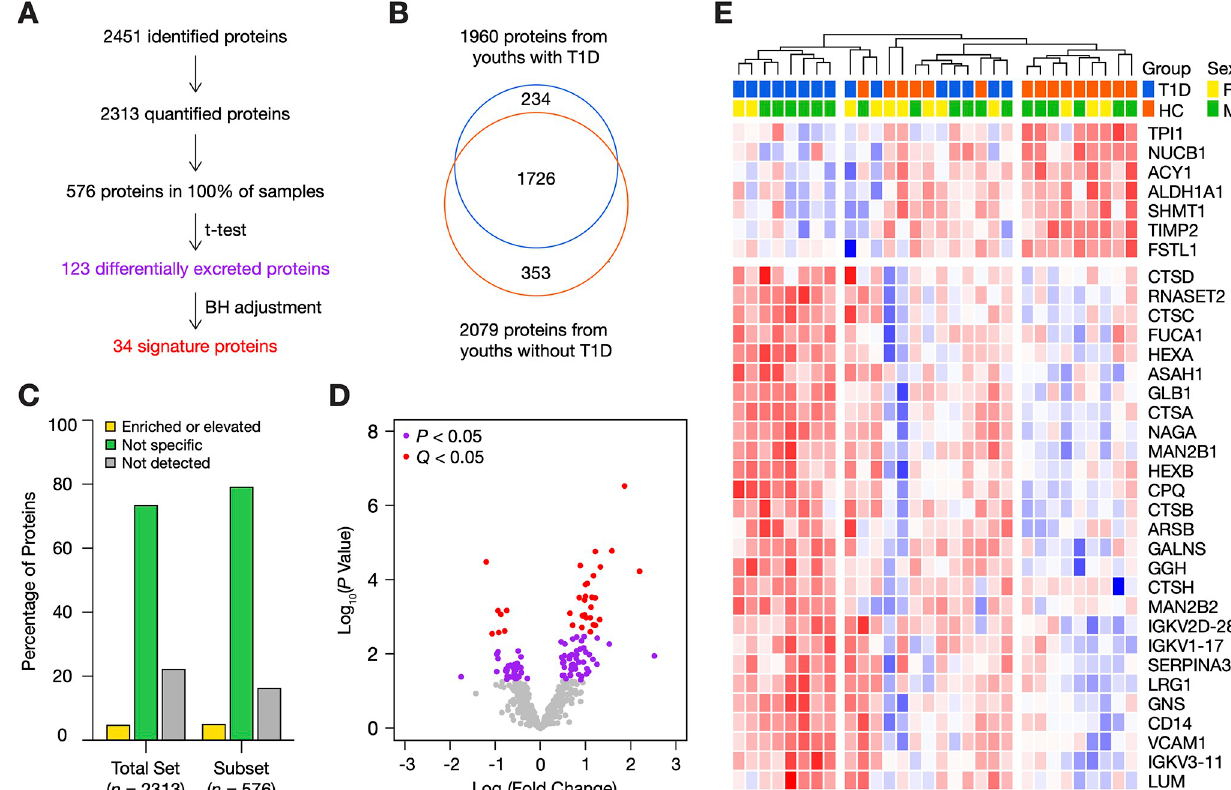
Fig 2. Characterization of the urinary proteomes of 15 youths with type 1 diabetes and 15 non-diabetic peers. (A) Flow diagram for the identification of the urinary signature of early type 1 diabetes. (B) Venn diagram of the 2313 quantified urinary proteins. (C) Kidney tissue origins of the total proteome and the subset of 576 proteins using the Human Protein Atlas. (D) Volcano plot of the 576 proteins found in all samples. A total of 123 proteins was differentially excreted (independent two-sample Student’s t-test, P < 0.05, purple); and 34 survived BH adjustment ( Q < 0.05, red). Higher fold changes indicate that protein intensities were higher in type 1 diabetes. (E) Heatmap representation of the 34 signature proteins with unsupervised clustering of samples. Log-transformed intensities were converted into z -scores. Scores were coloured on a blue (low) to red (high) gradient. F, female; HC, non- diabetic youths; M, male; T1D, youths with type 1